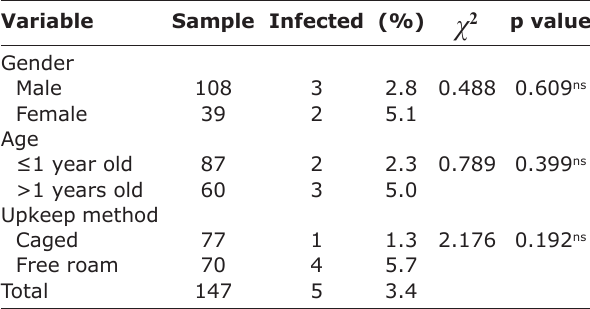
Table-1: Seroprevalence of N. caninum in Bali local dogs in